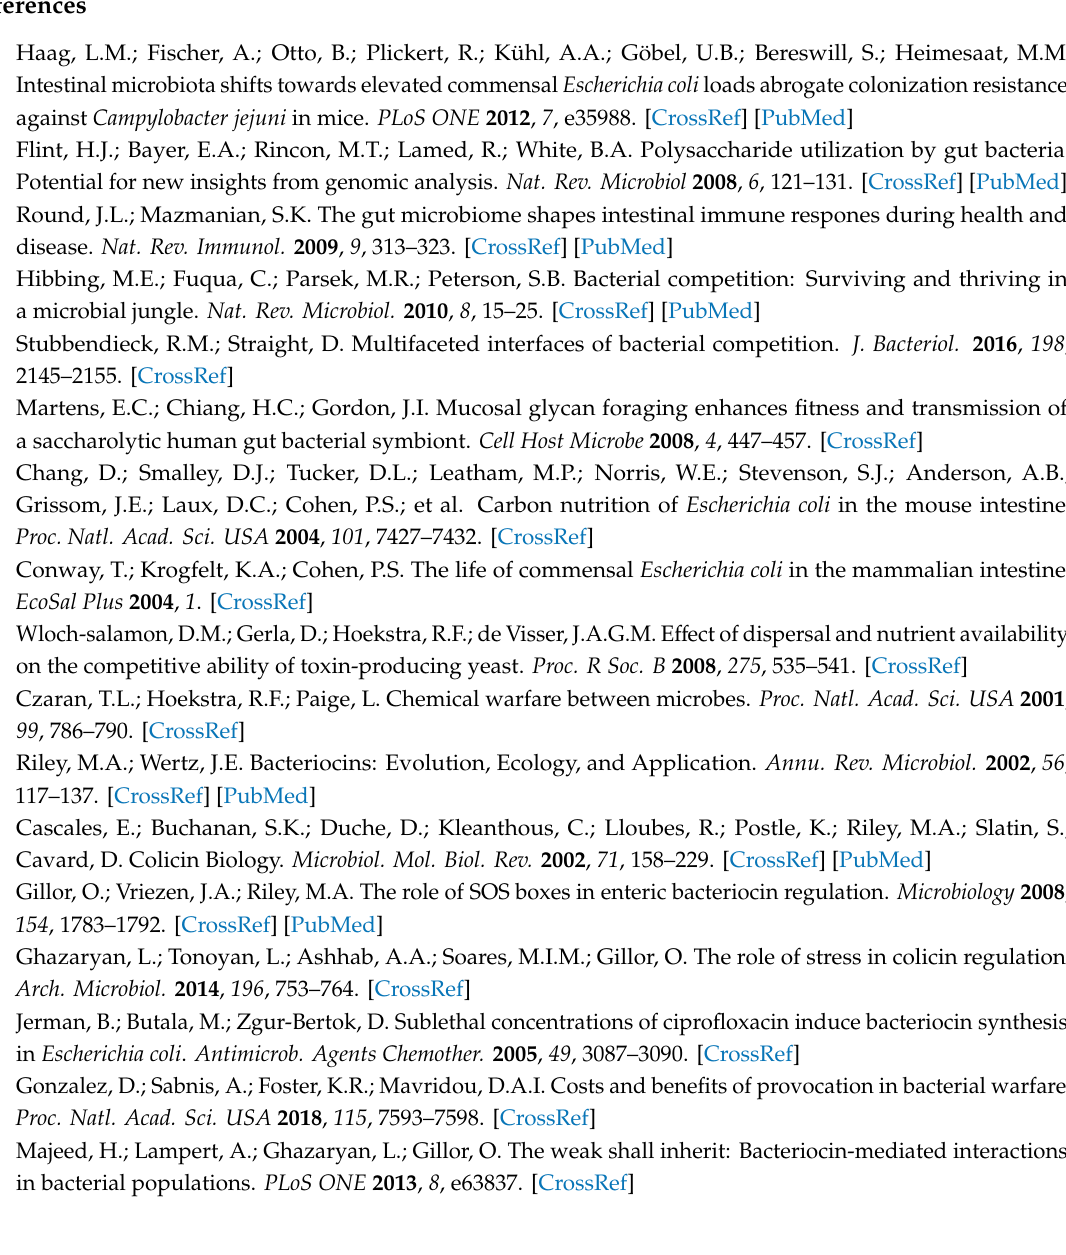
Figure S1: Schematic of MP1 plasmid map, Figure S2: SOS regulation of colicin promotor, Table S1: Characteristic and sensitivity profile of strains used to test activity of MP1 colicin. Supplementary